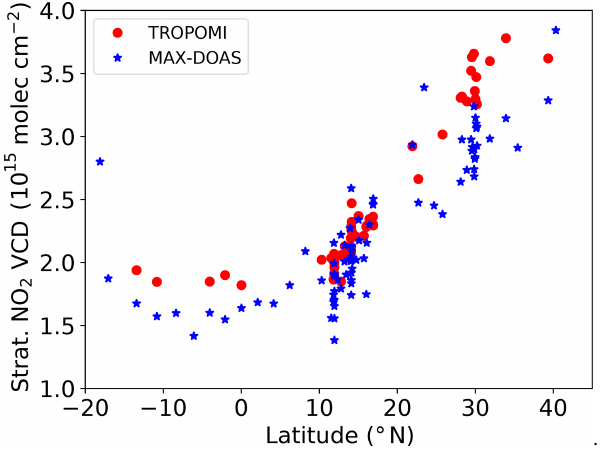
Figure 9. TROPOMI and MAX-DOAS stratospheric NO 2 vertical column densities as a function of latitude. Same data as in Fig.